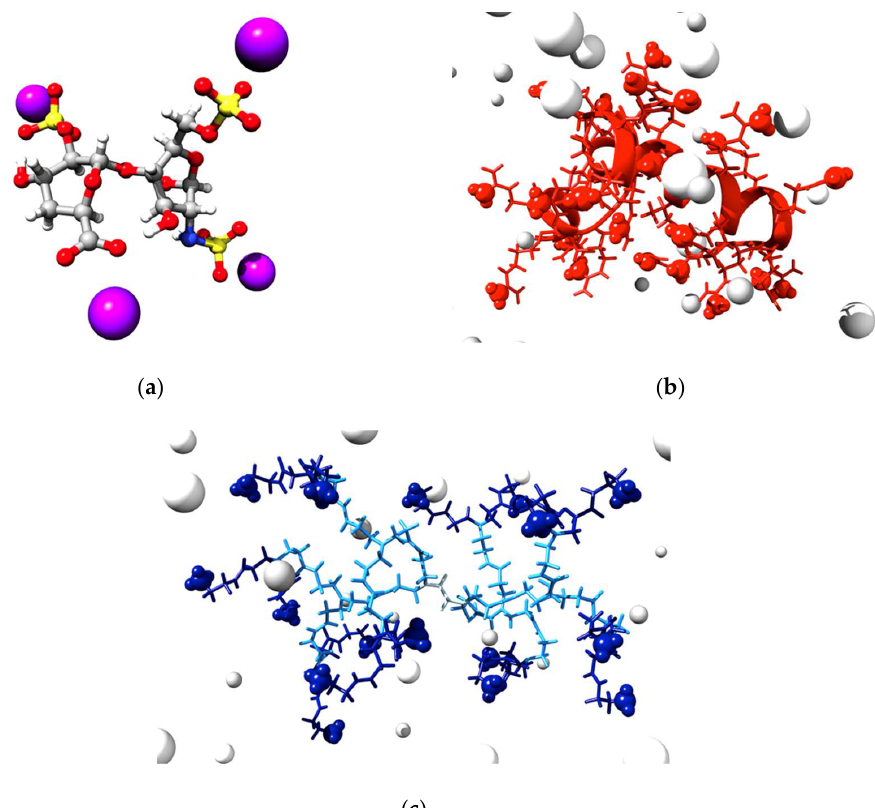
Figure 1. ( a ) Molecular model of the average repeating unit of heparin shown as atom-colored sticks-and-balls ( c ), gray; O, red; N, blue; S, yellow; H, white. Na + counterions are portrayed as purple spheres. ( b ) Molecular model of protamine structure in physiological solution. The small protein backbone is evidenced by a red ribbon, while the residues are shown as red sticks. One of the guanidinio –NH 2 groups is highlighted using red spheres. ( c ) Molecular model of a generation 2 (G 2 ) ethylenediamine (EDA)-core poly(amidoamine) (PAMAM) dendrimer structure in physiological solution. The dendrimer EDA core is shown as light blue sticks, the branching units are depicted as dodger blue sticks, while the branches and the relevant surface amine groups, positively charged at pH 7.4, are highlighted as navy blue spheres. In panels b , c , Na + and Cl − ions and counterions are represented by small and large white spheres, respectively, while water molecules are not shown for clarity.